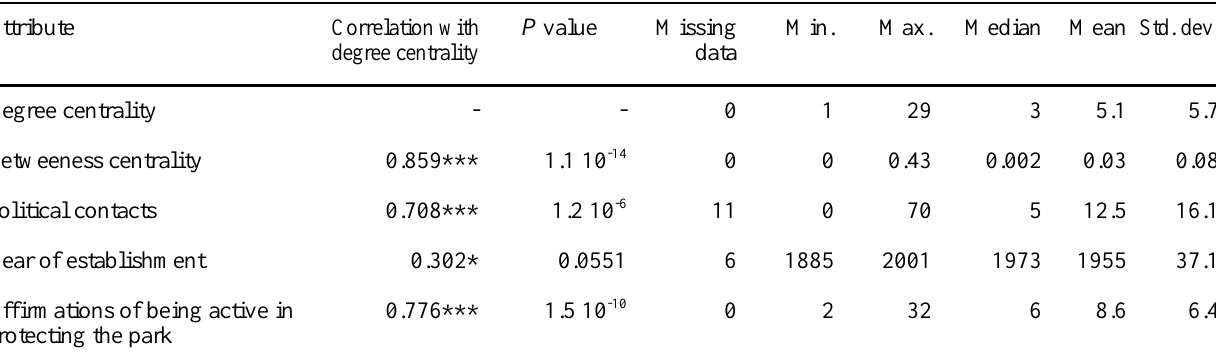
Table 1. The table gives correlation values between degree centrality and selected SMO attributes in the Main Component. For other organizational attributes in the study, correlation values gave too large p values to be significant. Number of nodes for all calculations was 47 ( N =